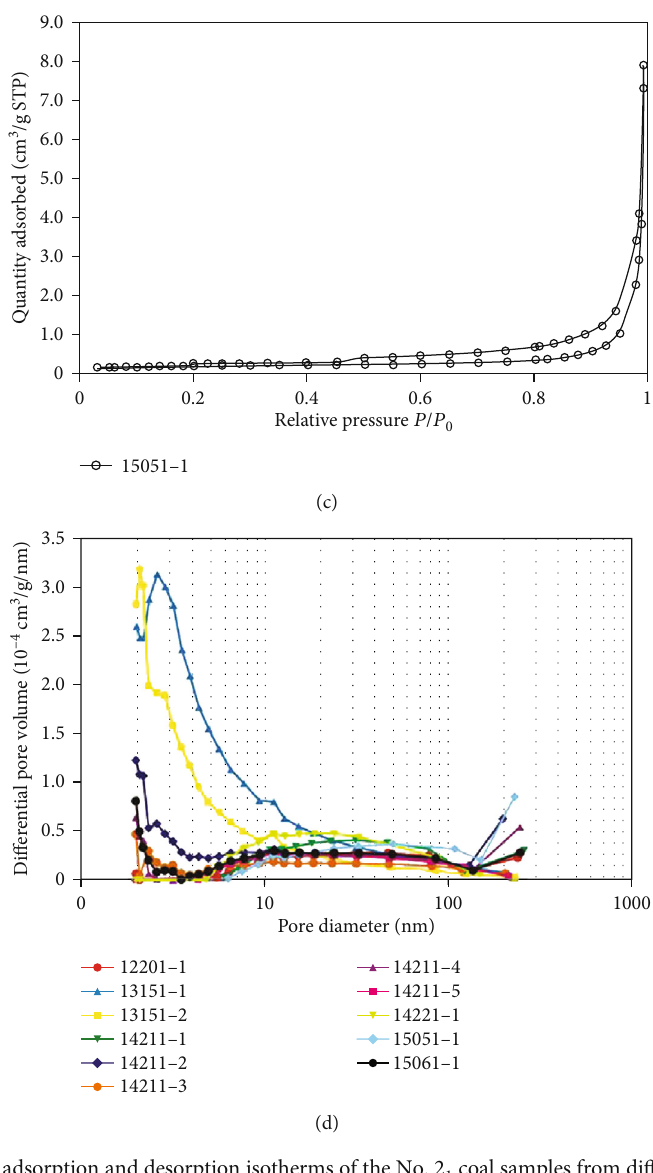
adsorption and desorption isotherms of the No. 2 2